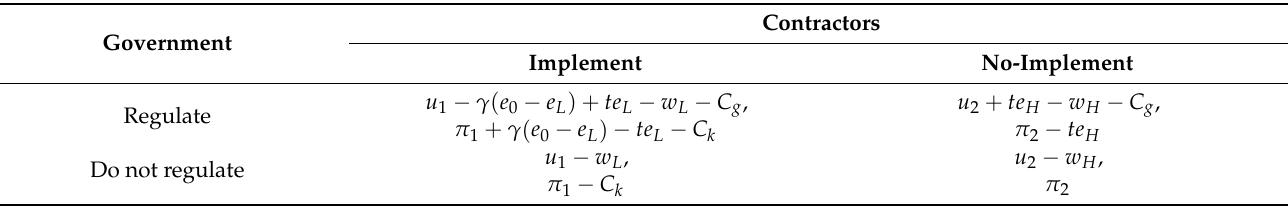
Table 2. Payoff matrix between the governments and the